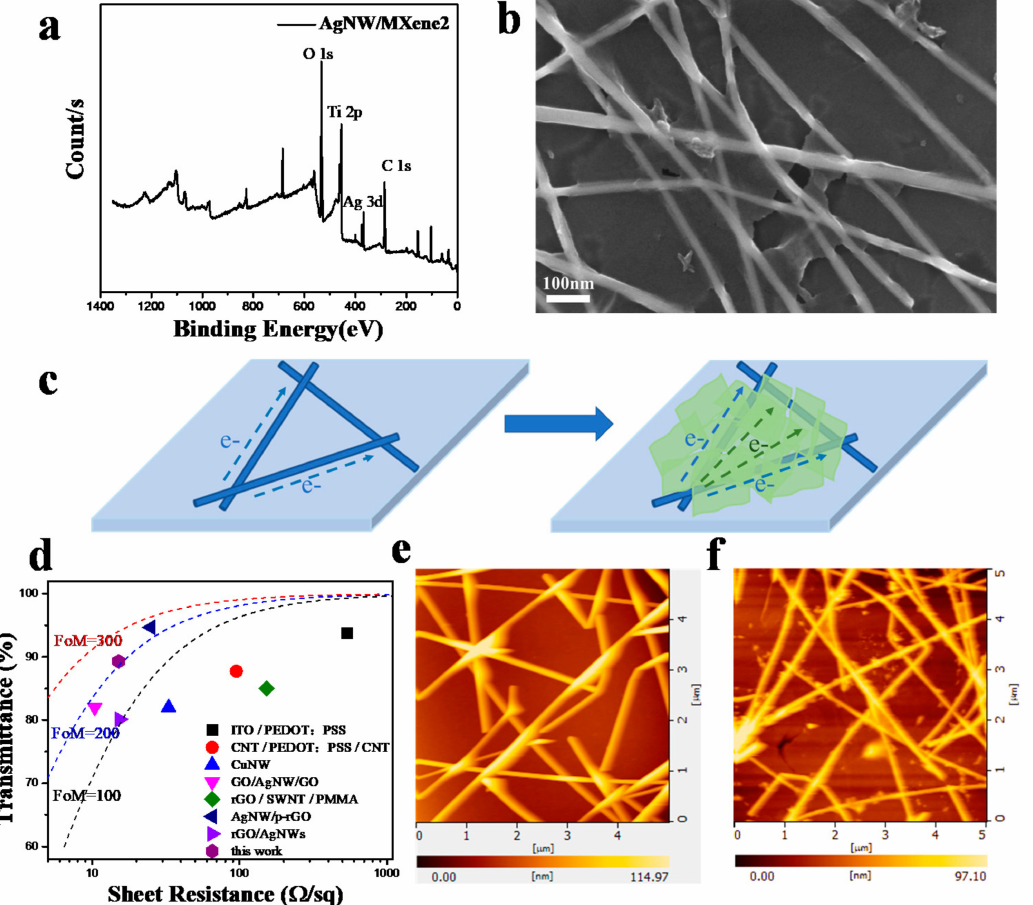
Figure 3. ( a , b ) XPS, SEM images of the AgNW/MXene2 hybrid films. ( c ) Schematic diagram of bridge effect. ( d ) Comparison of the optoelectronic performance of the AgNW/MXene electrode with those in previous works. ( e , f ) AFM images of the AgNW and AgNW/MXene2